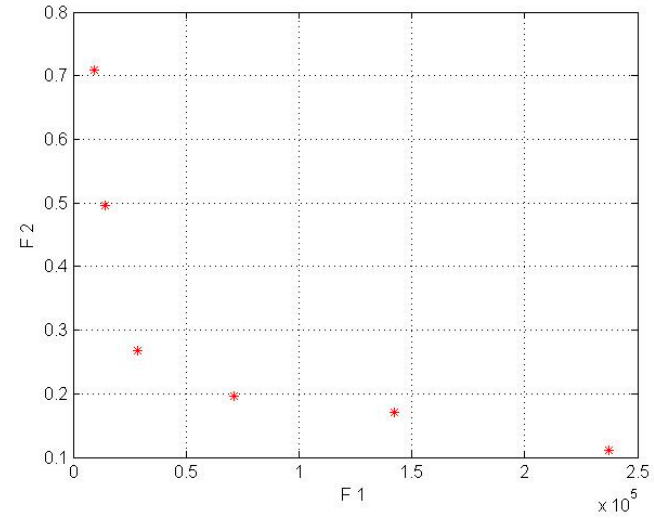
Figure 6. Pareto front for Firoozkooh in the wind lens turbine model (* shows COE by AEP )